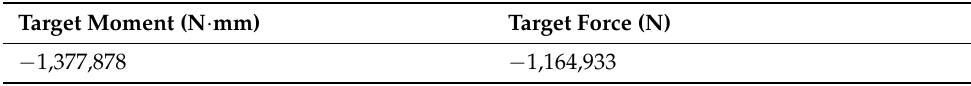
Table 4. Equivalent load by pass. Table 5. Target equivalent loads for final distortion